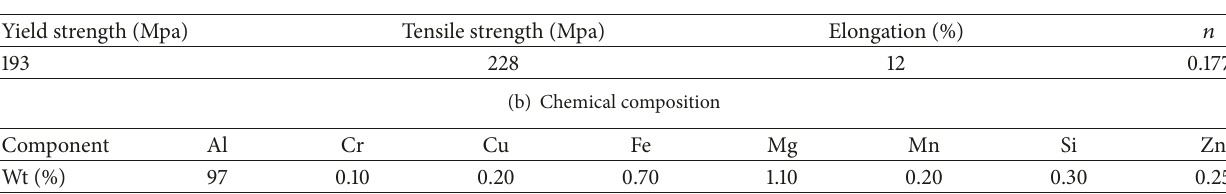
Table 1: Material characteristics for A5052-H32.